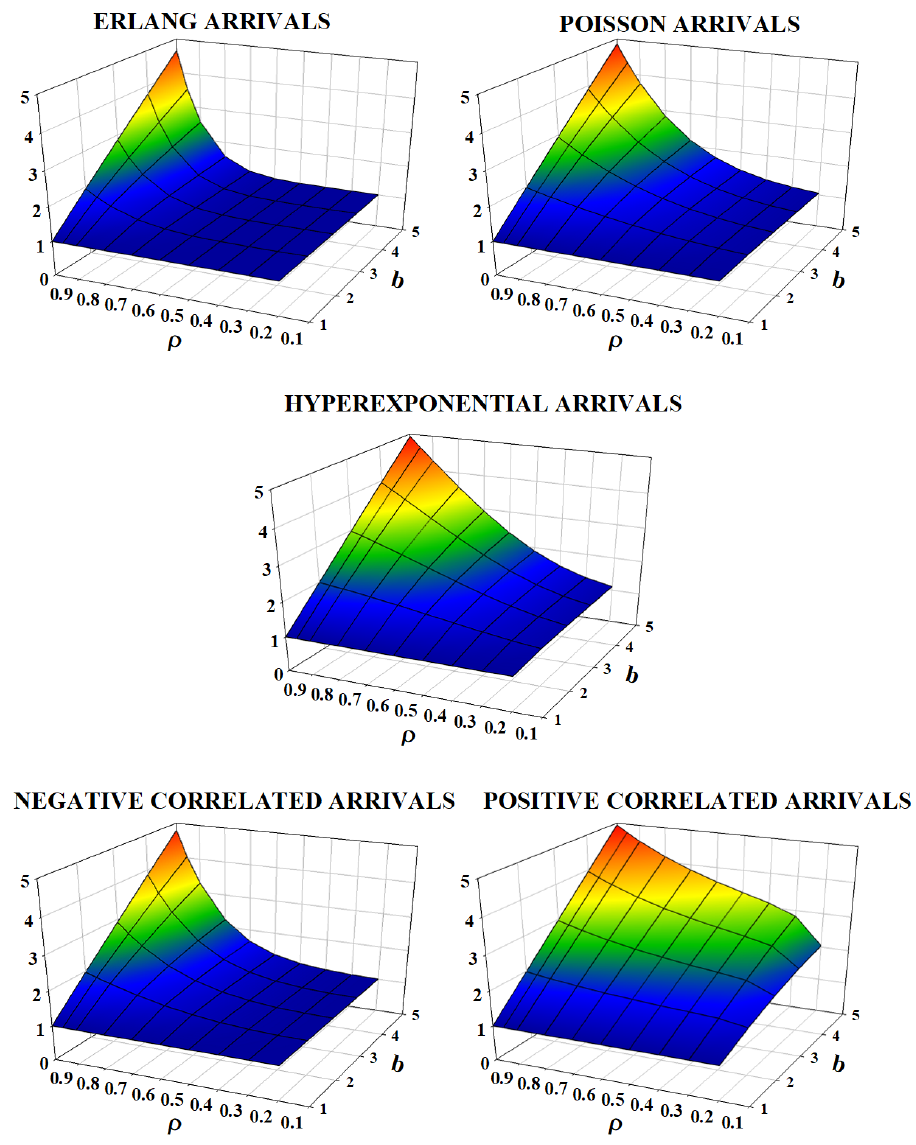
Figure 1. Conditional mean number in service ( µ NiS ) for example